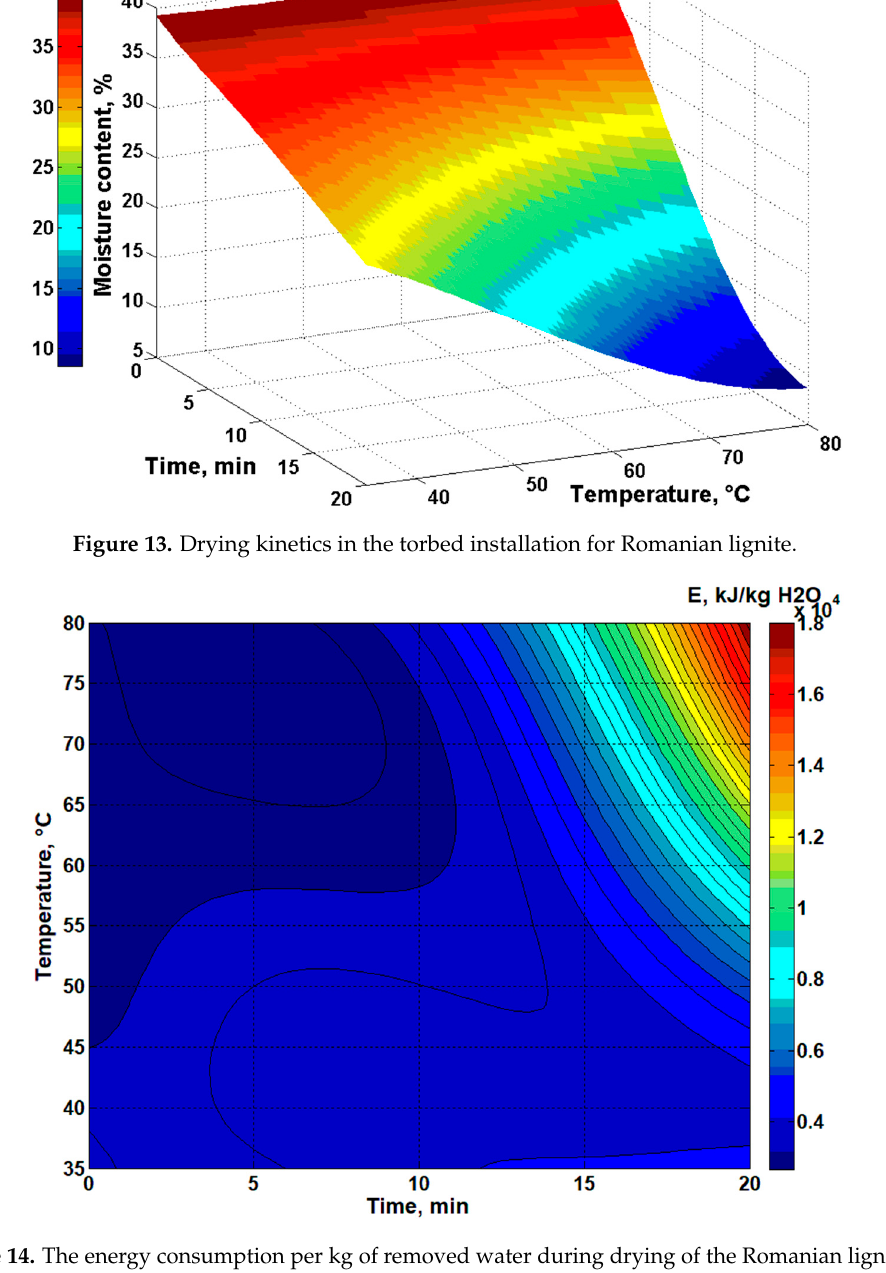
Figure 14. The energy consumption per kg of removed water during drying of the Romanian lignite in the torbed installation.